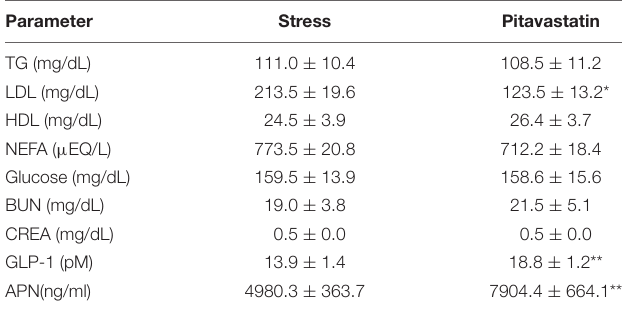
Abbreviations are in Table 2 . APN, adiponectin. Data are presented as means ± SEM, *P < 0.05, ** P < 0.01 vs. corresponding controls by Student’s un-paired